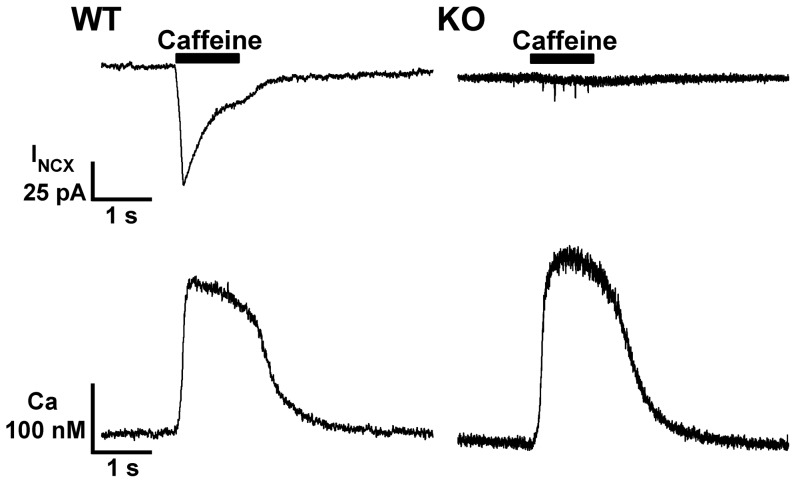
Caffeine-induced NCX currents and SR Ca load in WT and NCX1 knockout SAN cells.Membrane current (top) and Ca transients (bottom) from representative patch clamped WT (left) and KO (right) SAN cells loaded with the Ca-indicator fura-2. Cells were held at a constant voltage of -40 mV. A 1 s administration of bath solution containing 5 mM caffeine (black bar, upper panels) released SR Ca stores producing similar Ca transients in both cell types (bottom panels). The caffeine-induced Ca transient always produced an inward NCX current (INCX) in WT cells (top left), but never in KO (top right) despite Ca transients of normal kinetics and amplitude (see text for details).